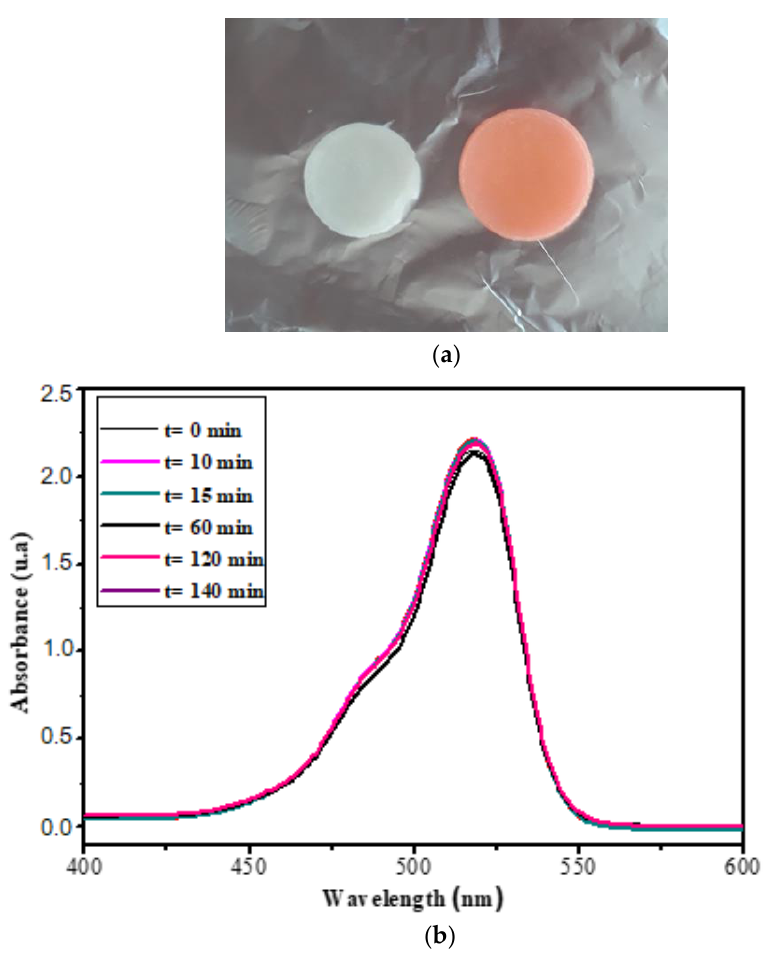
Figure 15. IPN c hydrogel before (left side) and after dye absorption ( a ). Absorption kinetics of eosin Y by IPN (cellulose–PHEMA hydrogels) ( b ).